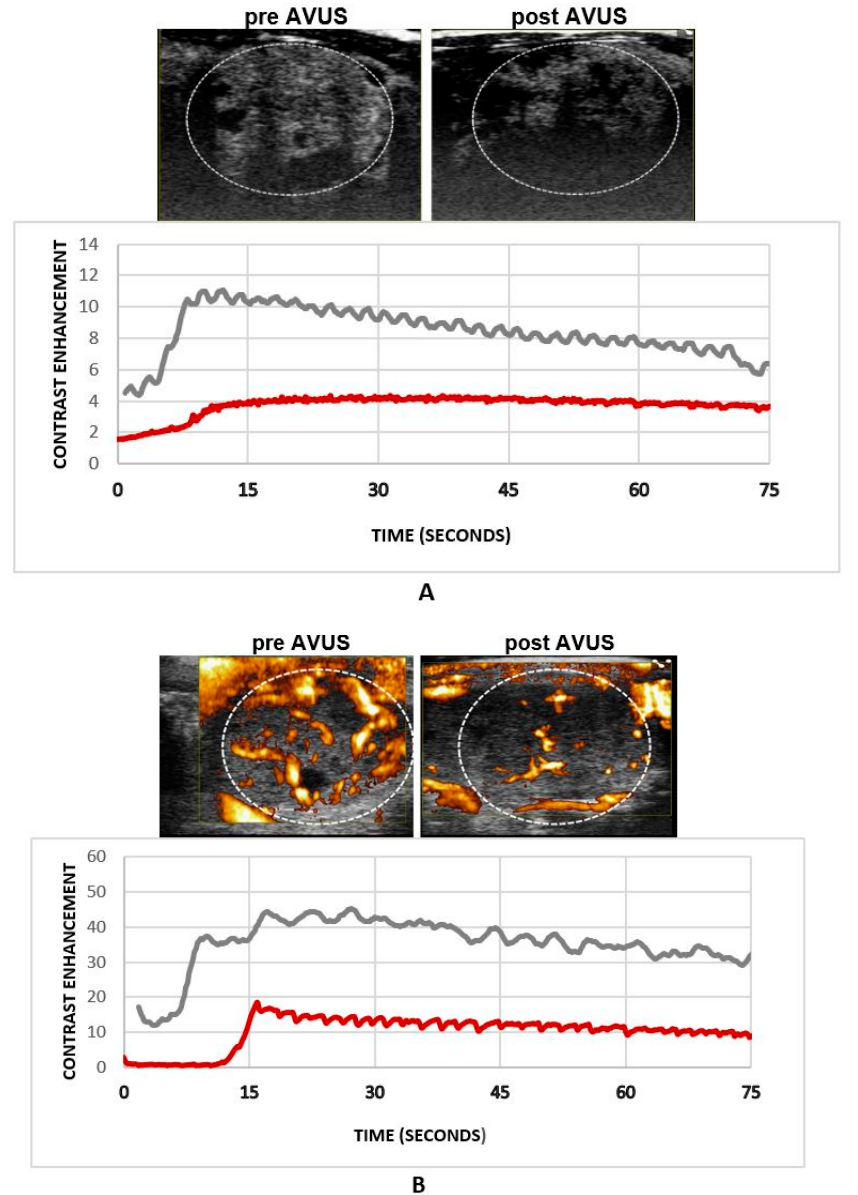
Figure 4. An example of an HCC tumor that received subsequent therapies within two days. Both panels ( A ) and ( B ) demonstrated a reduction in tumor perfusion after therapy in this case.